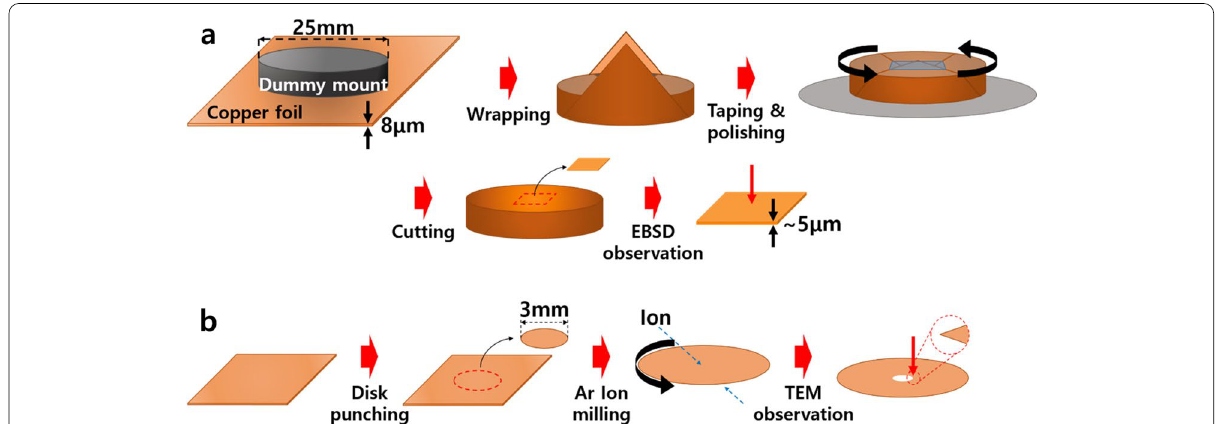
Fig. 1 Schematic diagram of copper foil preparation for a EBSD and b TEM in plane view